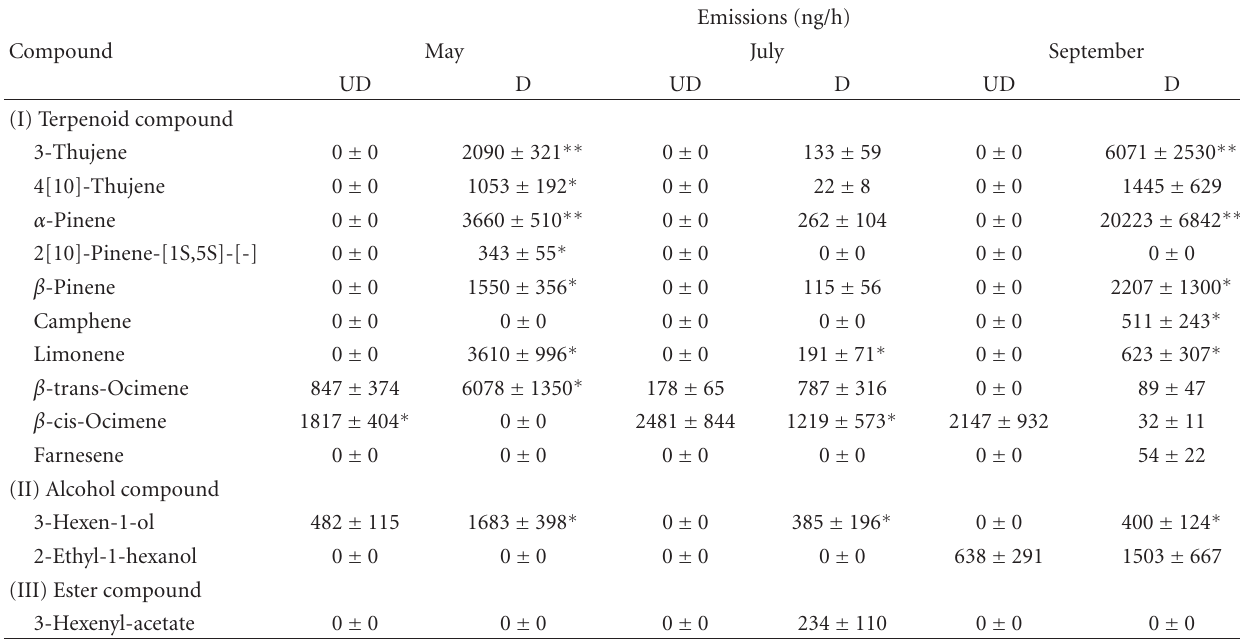
Table 3: Comparison of volatile compounds (mean ± SE) detected by GC/MS from wax scale-damaged and undamaged persimmon